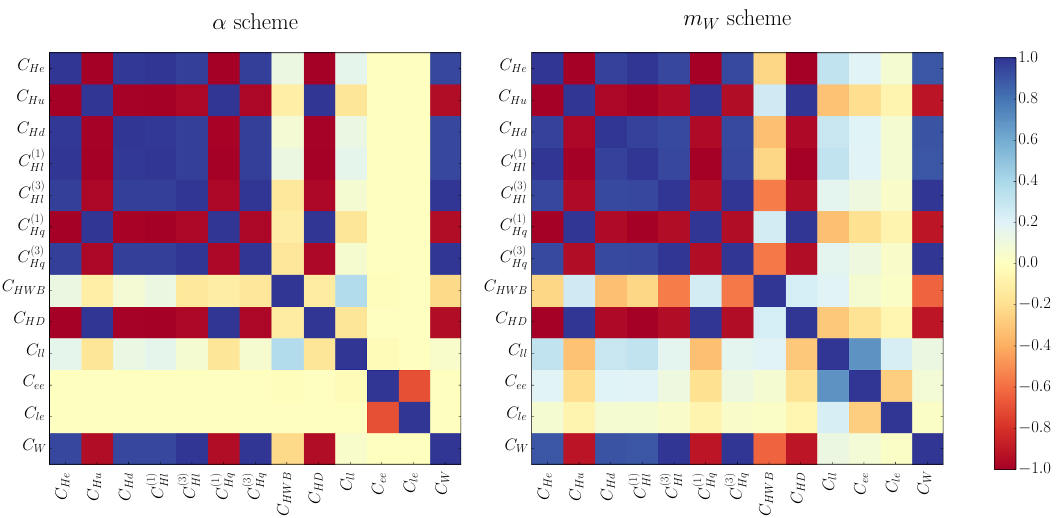
Figure 5 . Color map of the correlation matrix among the Wilson coe(cid:14)cients, obtained assuming zero SMEFT error, for the scheme